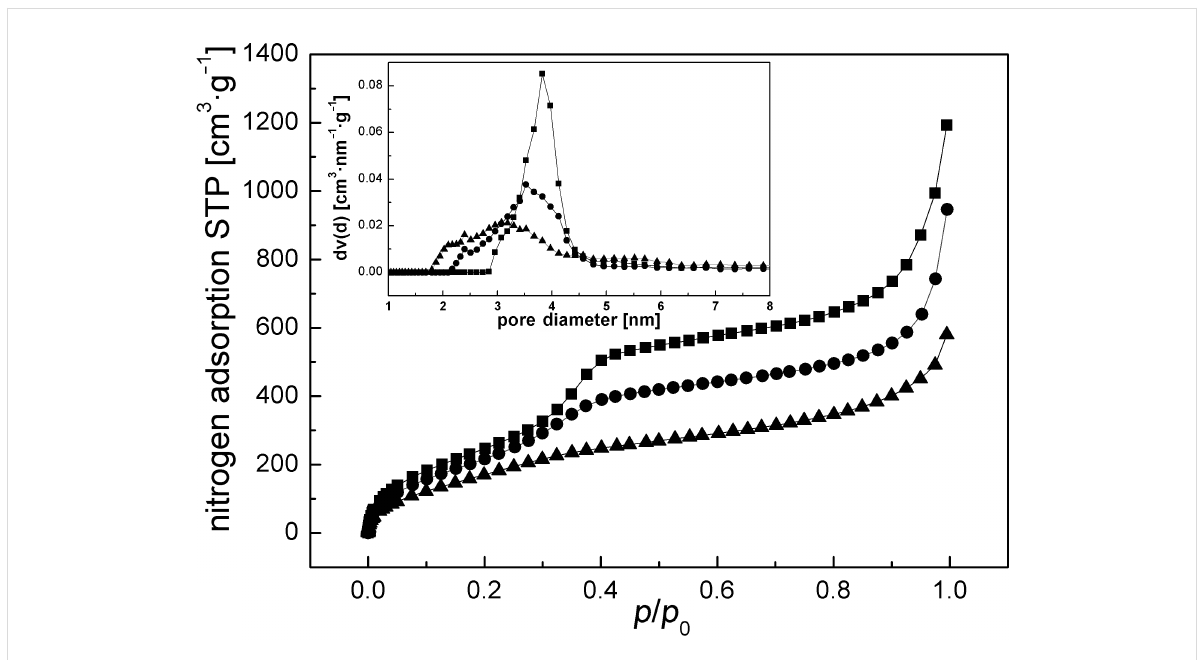
Figure 1: Nitrogen adsorption isotherms and pore diameters (inset); (squares) benzene-PMO, (circles) benzene-PMO-(0.81 mmol SO 3 H·g − 1 ) grafted on silanol groups, (triangles) benzene-PMO-(1.65 mmol SO 3 H·g − 1 ) grafted on silanol and benzene